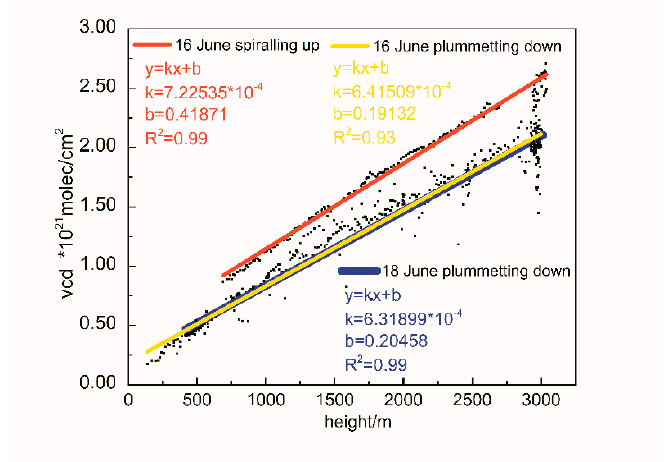
Figure 14. Linear relationship between CO 2 column and altitudes during spiraling up and plummeting down stages.